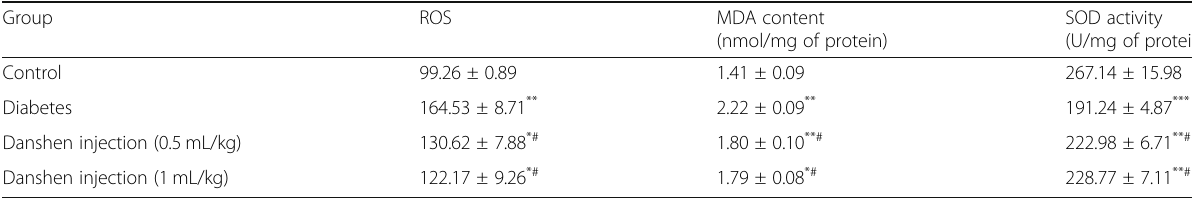
(U/mg of protein)